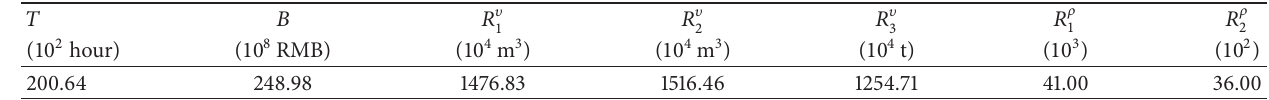
Table 5: Some fixed data in hydropower construction project 𝑋 .